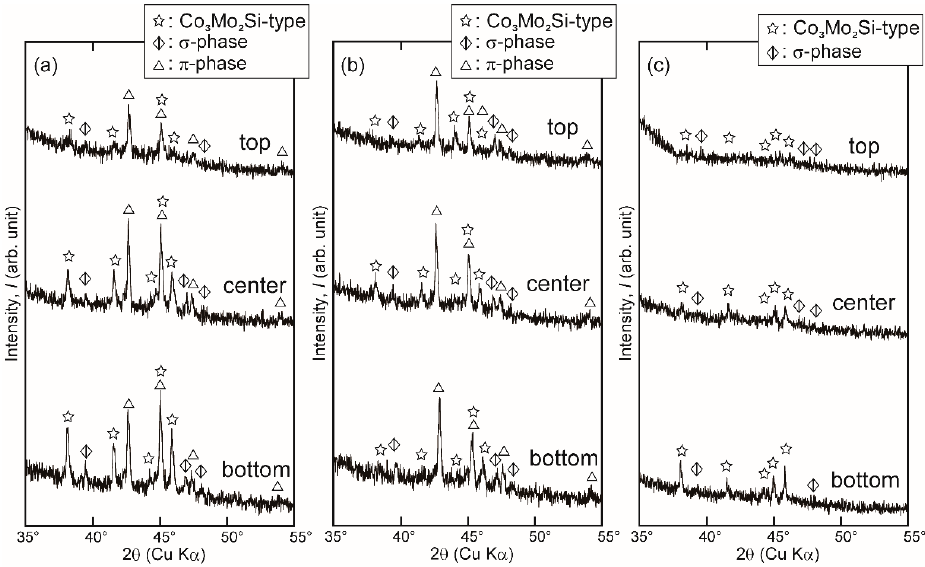
Figure 7. XRD patterns of the precipitates electrolytically extracted from the ( a ) as-built, ( b ) aged, and ( c ) reversely transformed specimens of the low-C alloy.